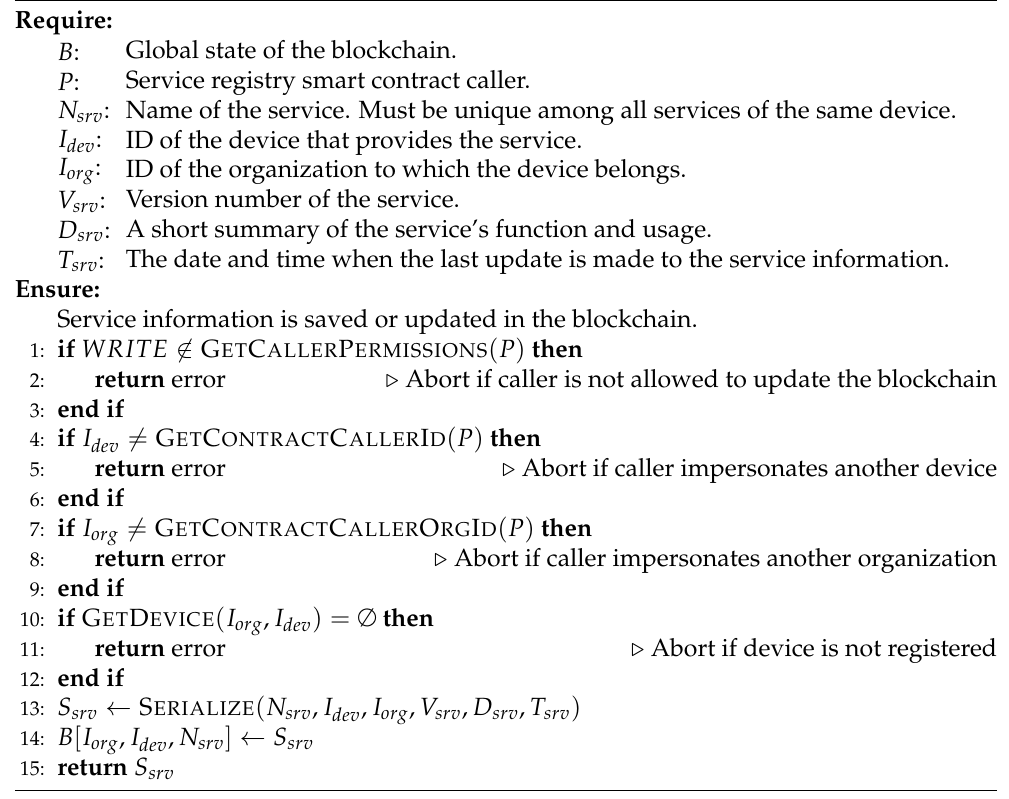
Algorithm 2 Registering a service with the service